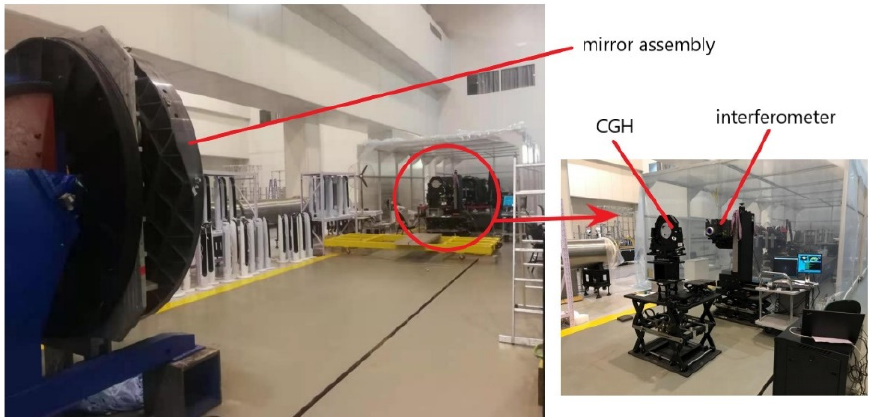
Figure 16. Detected mirror surface error using an interferometer.